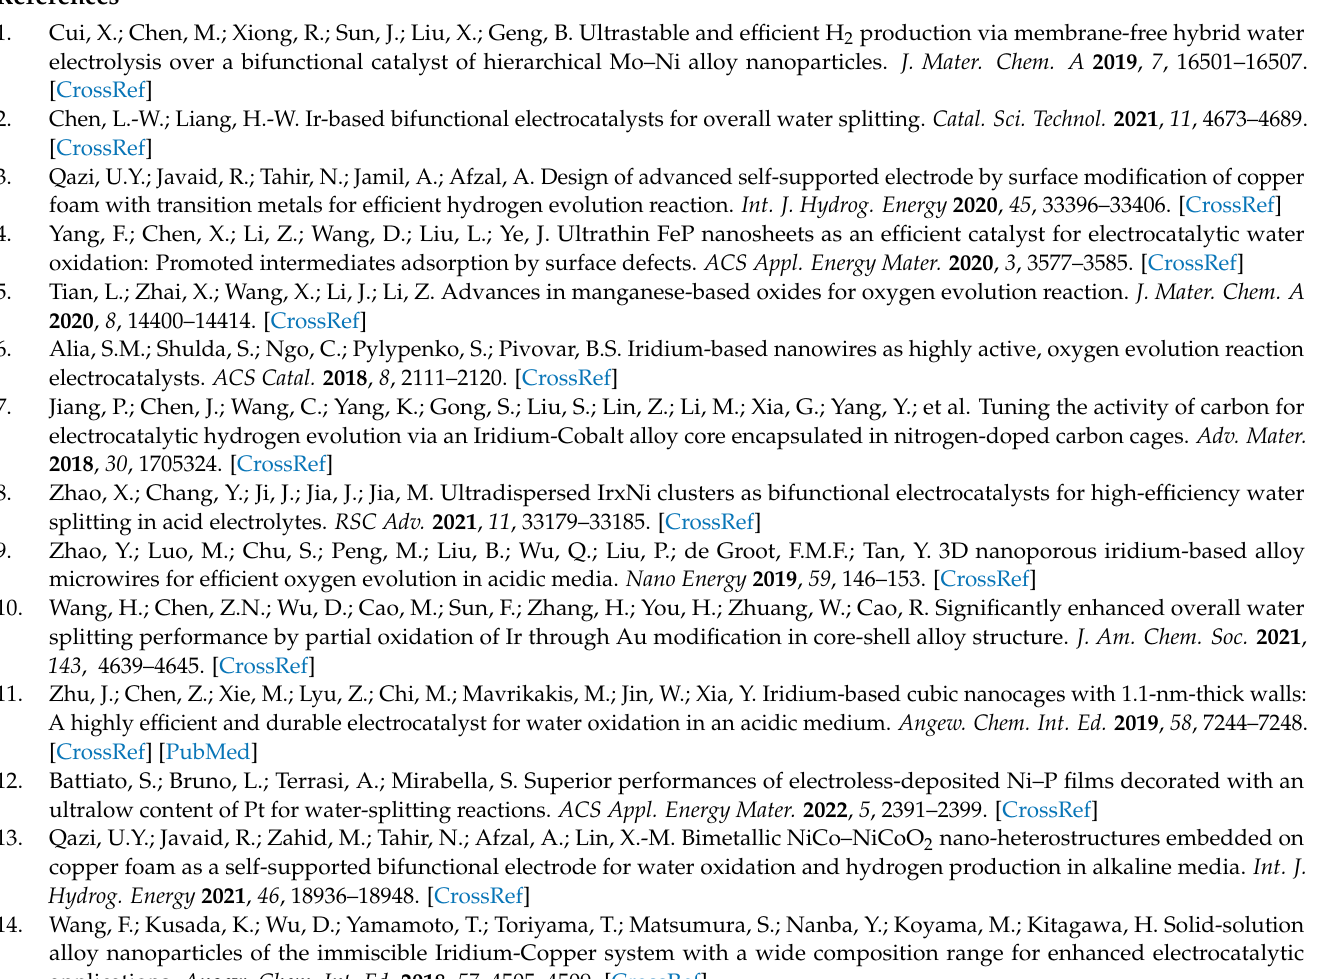
Figure S8: (a) LSV curves of the HER in 1 M KOH. (b) The overpotential at 100 mA cm − 2 . (c) EIS results of the catalysts. (d) Electrical double layer capacitor (C dl ); Table S1. Main reagents in the experiment; Table S2. Main instruments of the experiment; Table S3: Comparison of different catalysts; Table S4: Comparison of the OER performance of IrO 2 and RuO 2 with Ir 3 Co/C [8,27]; Table S5: OER electrocatalysts reported recently [19,28–31]; Table S6. HER electrocatalysts reported recently